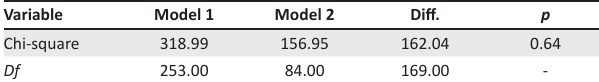
TABLE 6: Path analysis of the structural equation modelling prediction models. Scale